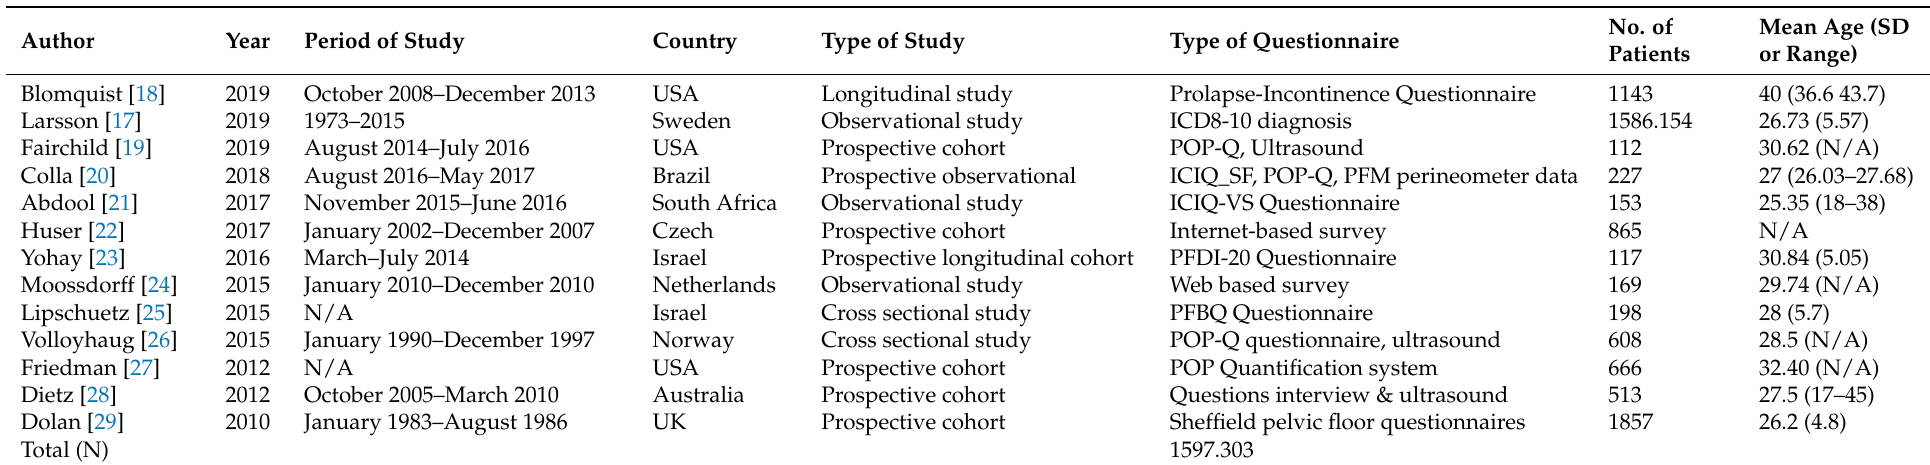
Table 1. Characteristics of the included